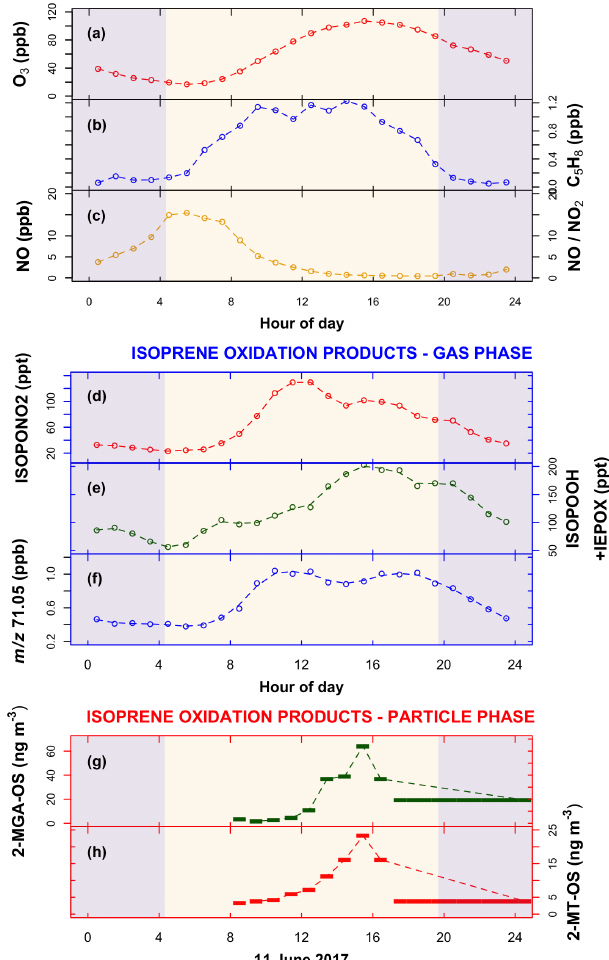
Figure 2. Mean diurnal variation in measured organic and inor- ganic species in the gas and aerosol phase during the Beijing sum- mer observations (data are filtered to only include typical chemistry days – see text for details; the standard deviation of the mean is shown in Fig. S3). Blue-shaded areas are nighttime. (a) Ozone (O 3 ); (b) isoprene (C 5 H 8 ); (c) nitric oxide (NO) and the ratio NO / NO 2 ; (d) the gas-phase isoprene high-NO oxidation product, isoprene nitrate (ISOPONO2); (e) the isoprene low-NO oxidation products ISOPOOH + IEPOX; (f) m/z 71.05, assumed to be predominantly the gas-phase isoprene high-NO oxidation products methacrolein (MACR) (precursor to 2-MGA) + methyl vinyl ketone (MVK), sig- nal calibrated with MACR and MVK – see text for further details. (g, h) SOA components: 2-methyltetrol-organosulfate (2-MT-OS) and 2-methylglyceric acid-organosulfate (2-MGA-OS), both mea- sured on 11 and 12 June 2017; the last filter sample was taken